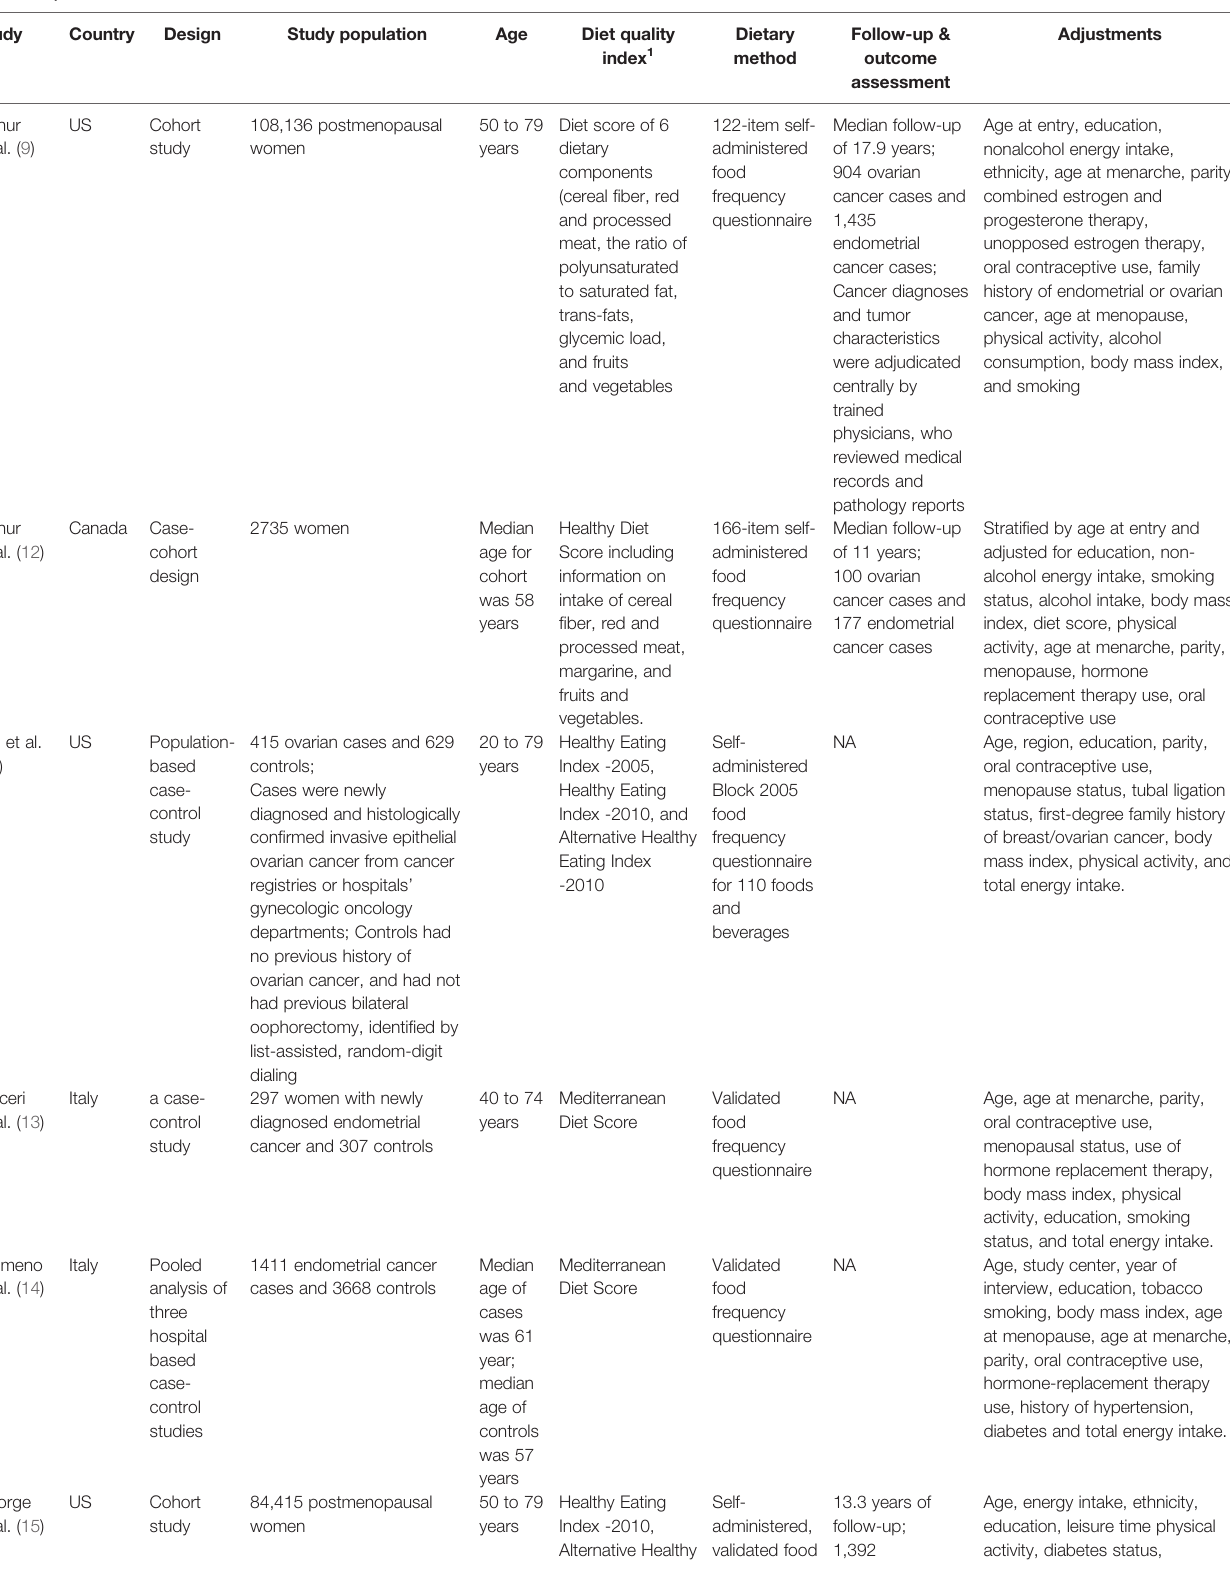
TABLE 1 | Characteristics of the studies included in the